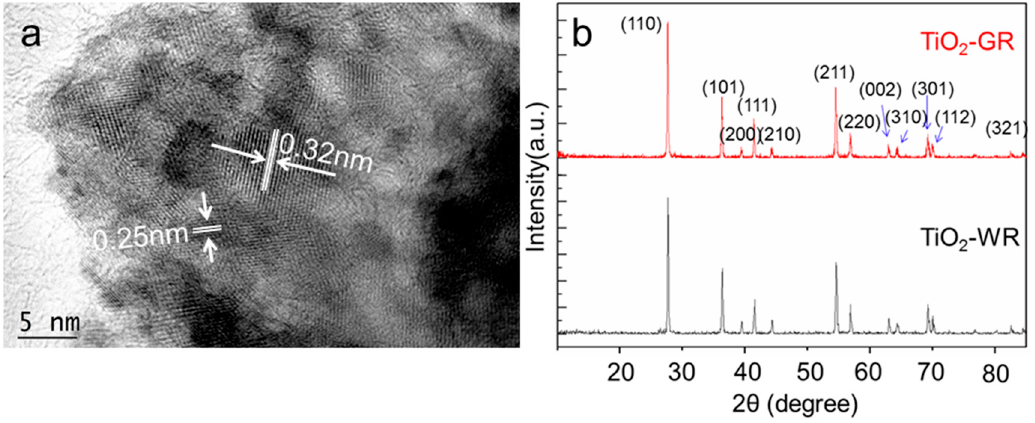
Figure 2. HRTEM ( a ) and XRD patterns ( b ) of gray rutile TiO 2 .